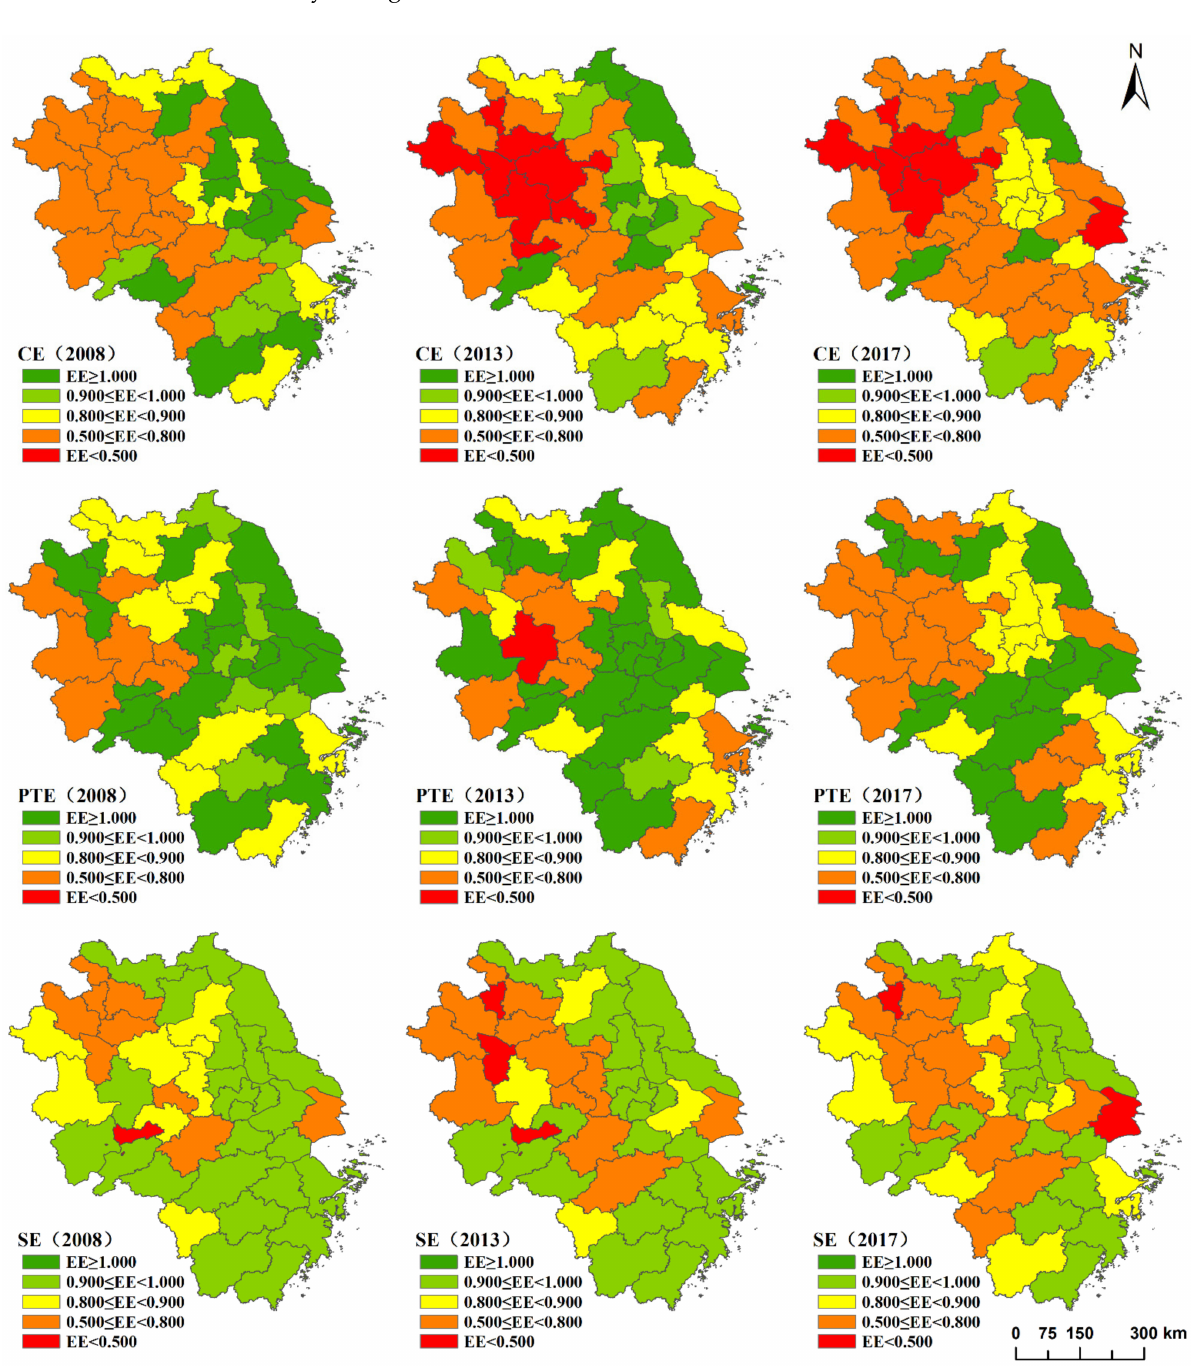
Figure 2. Spatial and temporal pattern evolution of tourism eco-efficiency in the Yangtze River Delta urban agglomeration. In 2008, 2013 and